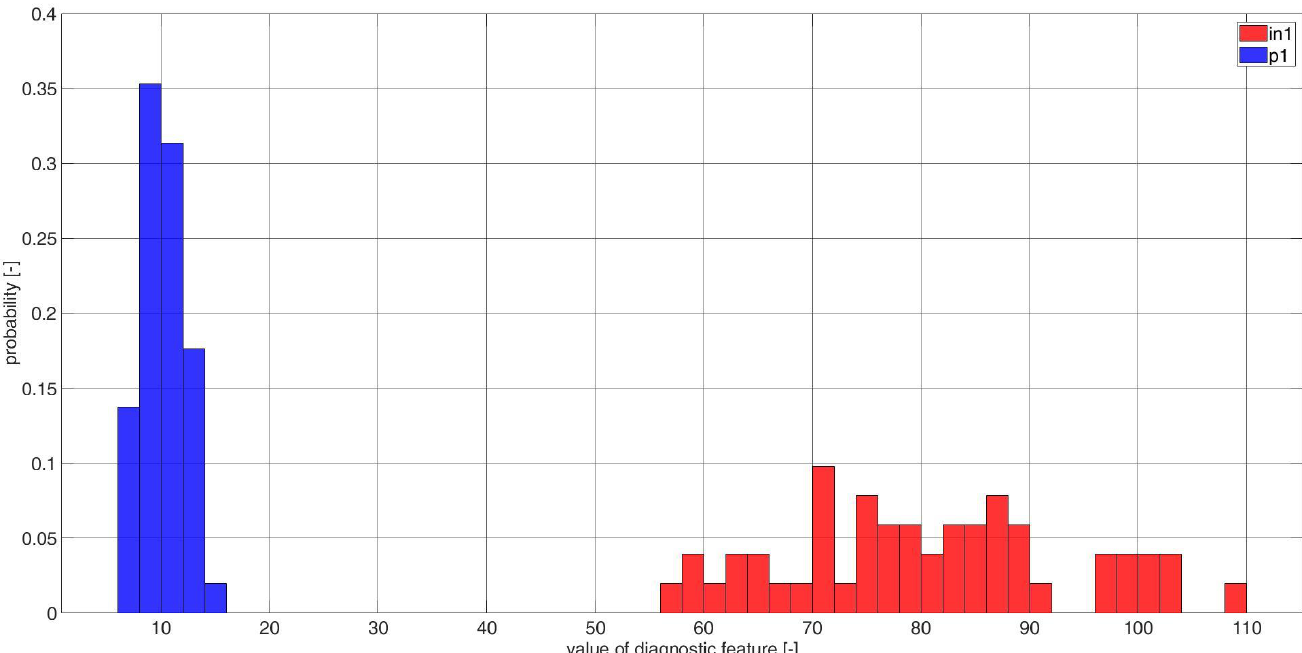
Figure A20. Histograms of diagnostic features based on the CCSM3 (correlation number is 21 — Table A1) bearings in2 and p2.